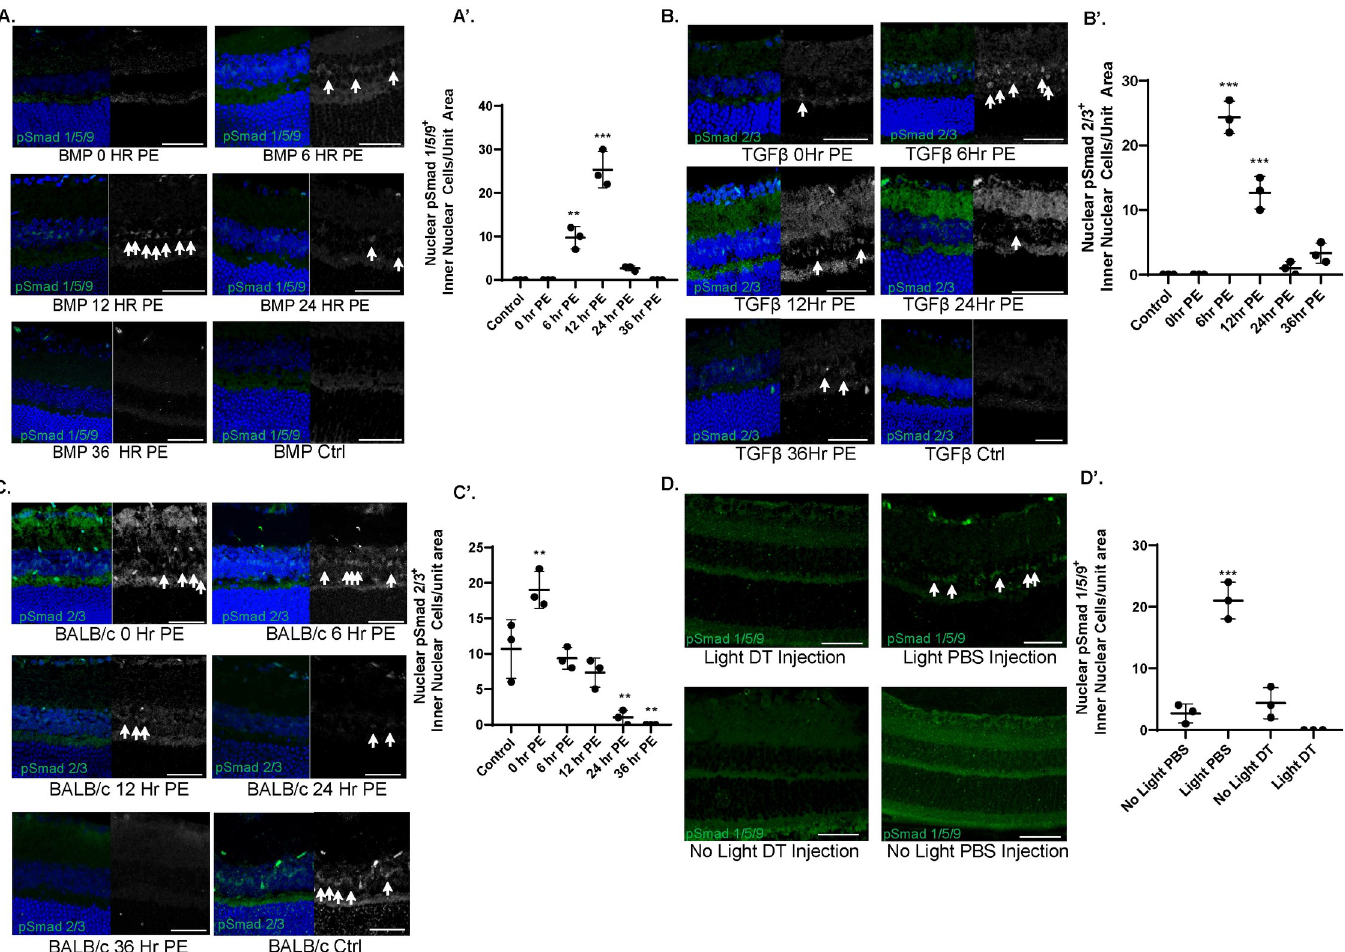
Fig 3. BMP and TGF β activation occurs in a time dependent manner following light stress and damage. Representative retinal images and quantitation of control dark adapted 3.5 m/o C57BL/6 mice, or 0, 6, 12, and 24 hours post exposure to 10,000 lux for 1.5 hours stained for pSmad 1/5/9 (in green, 3A-A’) and pSmad 2/3 (in green,3B-B’). Similar analysis of pSmad 2/3 in light-damaged BALB/c mice retinal sections (3-C). Representative retinal images and quantitation in 3.5 m/o CD11b::DTR mice treated with either diphtheria toxin or PBS control and exposed to 10,000 Lux. Sections were stained pSmad 1/5/9 (green) (3D-D’). Arrows (red) highlight pSmad expression in the inner retinal in all images. Scale Bar: 30 μ m. Experiments were conducted with n = 2 replicates and n = 3–5 mice/condition. Error bars indicate s.e.m. Pvalues from Student’s t-test. � p < 0.05, �� p < 0.01, �� p < 0.001. PE = post-exposure. DAPI (blue) marks nuclei in all panels.